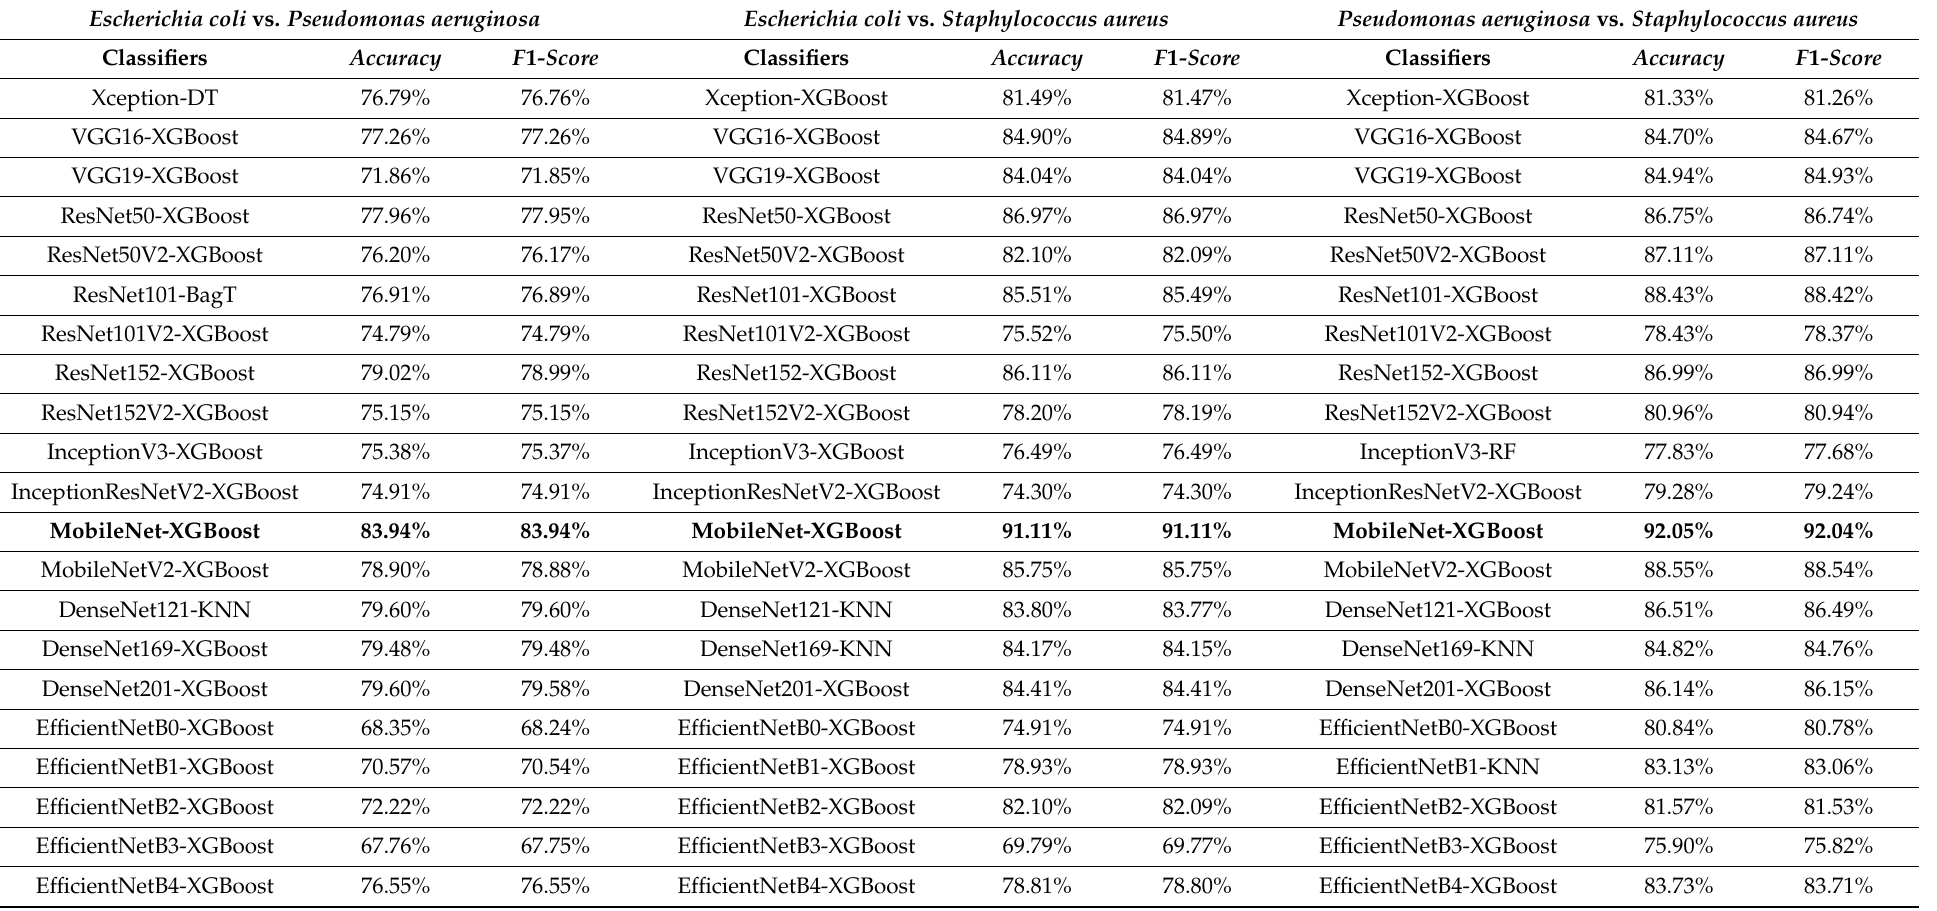
Table 3. Summary of the best discrimination results between study group pairs. Escherichia coli vs. Pseudomonas